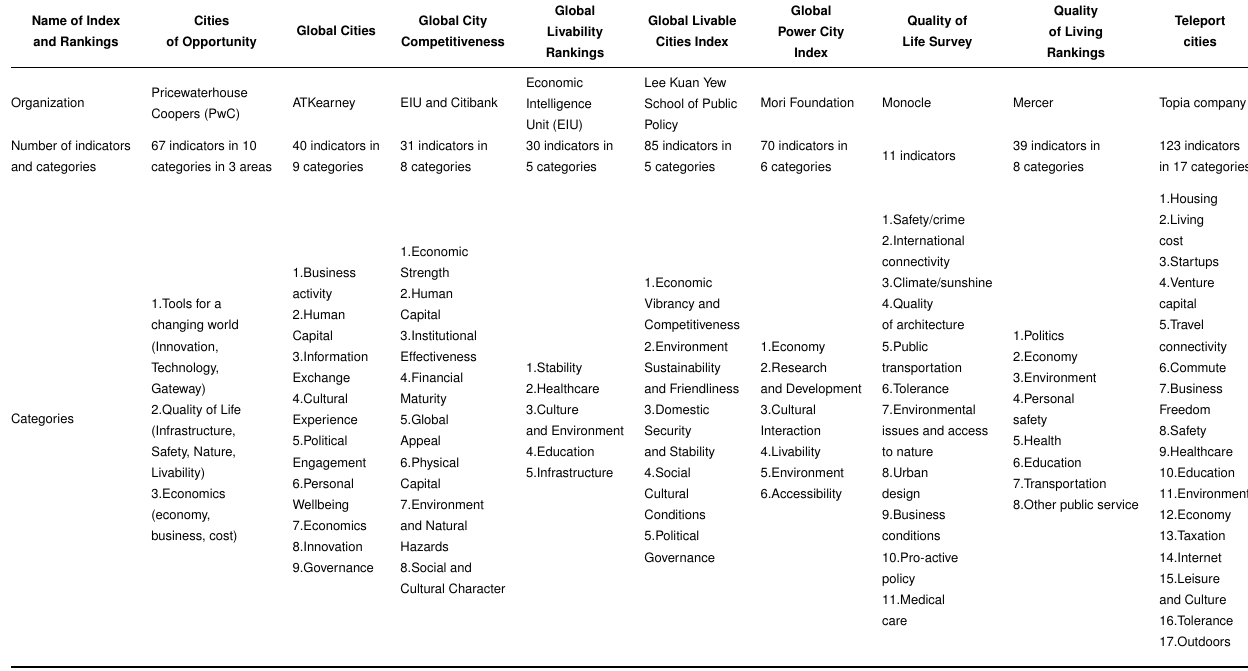
Table 1. Overview of nine selected livable city ranking schemes. Adapted from [21], and modified by the authors. NameofIndex